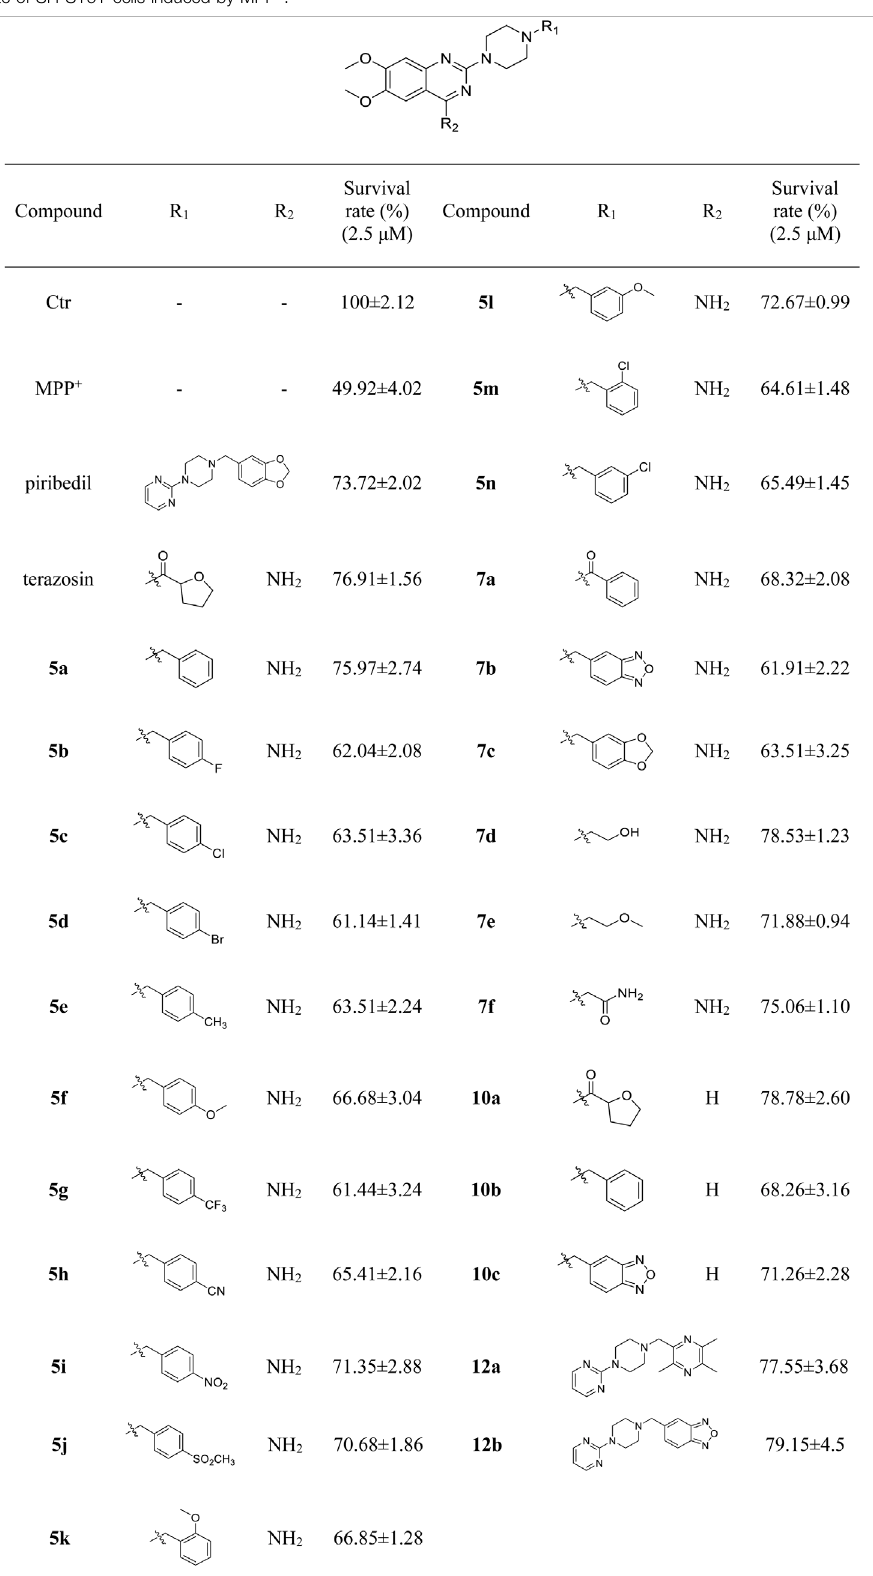
TABLE 1 | The survival rate of SH-SY5Y cells induced by MPP + .